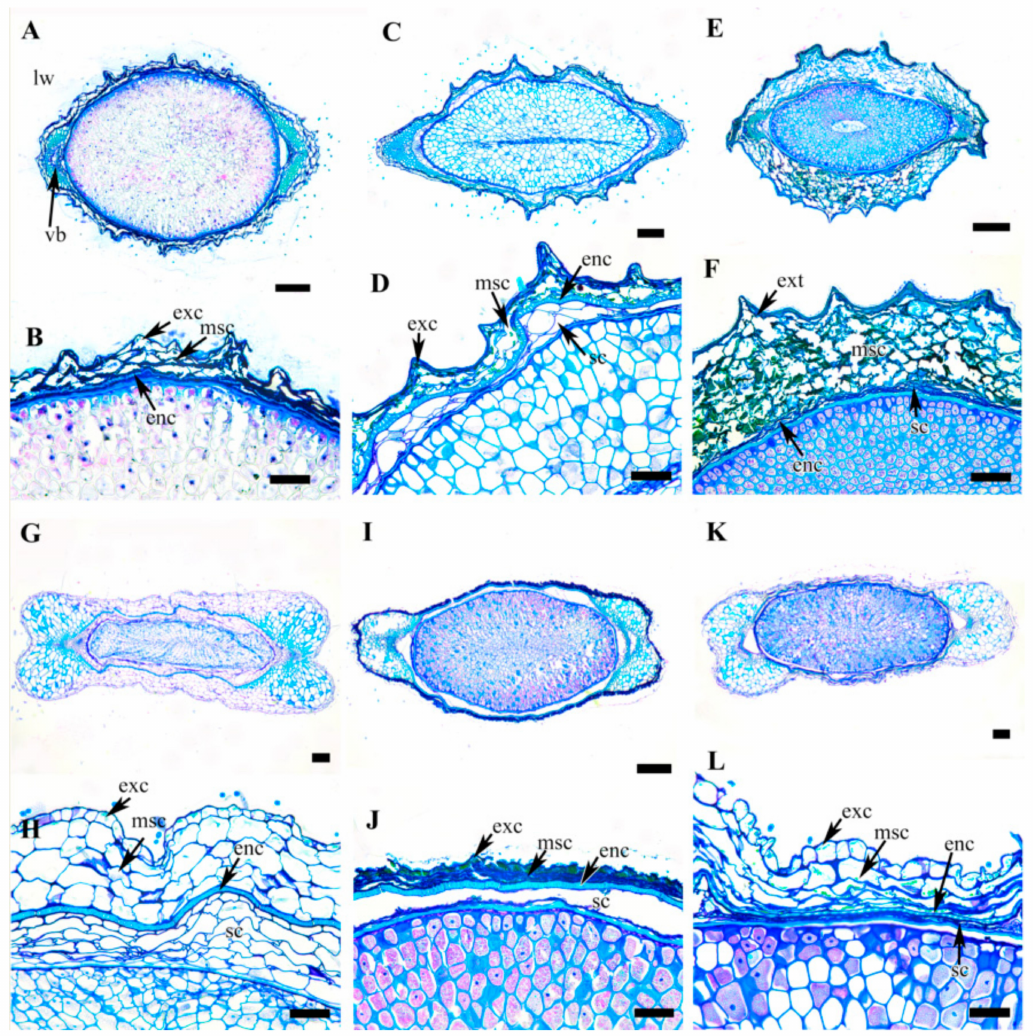
Figure 5. Cross section of achenes of Clematis . ( A , B ) C. apiifolia . ( C , D ) C. brevicaudata . ( E , F ) C. trichotoma . ( G , H ) C. taeguensis . ( I , J ) C. hexapetala . ( K , L ) C. terniflora . Abbreviations: enc, endocarp; exc, exocarp; lw, lateral wing; msc, mesocarp; sc, seed coat; vb, vascular bundle. Scale bars: 200 µ m ( A , C , E , G , I , K ); 100 µ m ( B , D , F , H , J , L